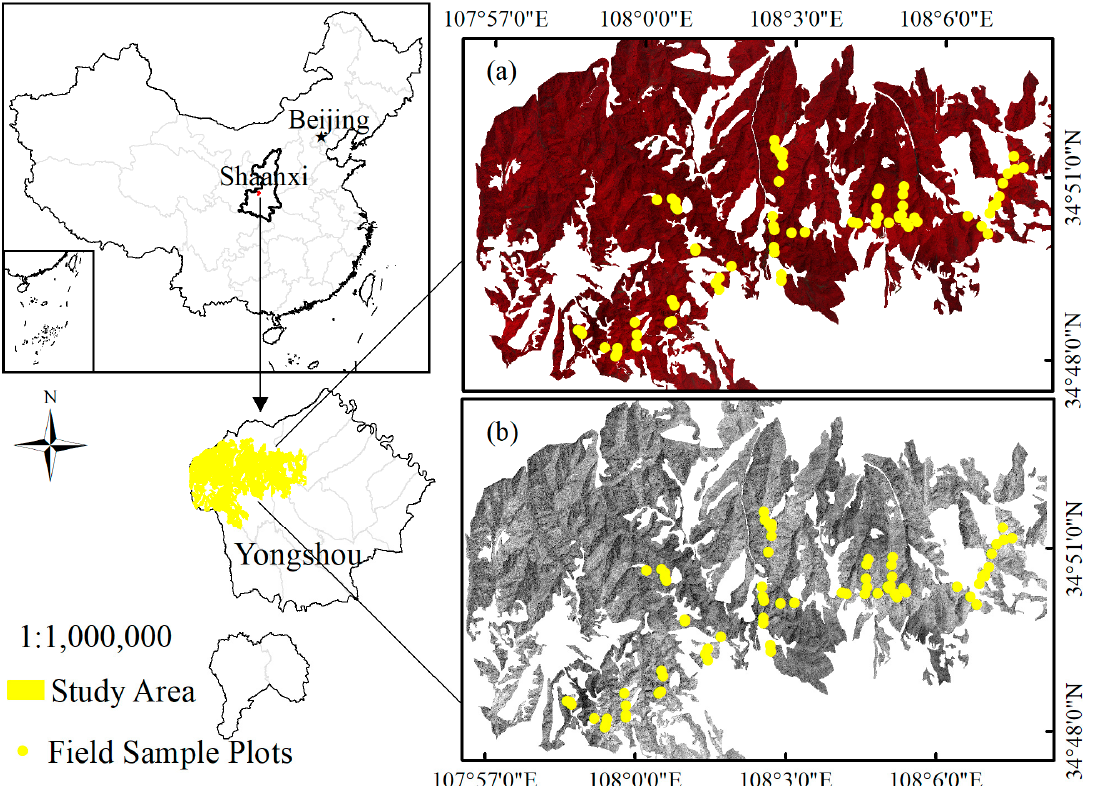
Figure 1. Location of the study area and the field sample plots identified from the multispectral ( a ) and panchromatic ( b ) data of QuickBird imagery.